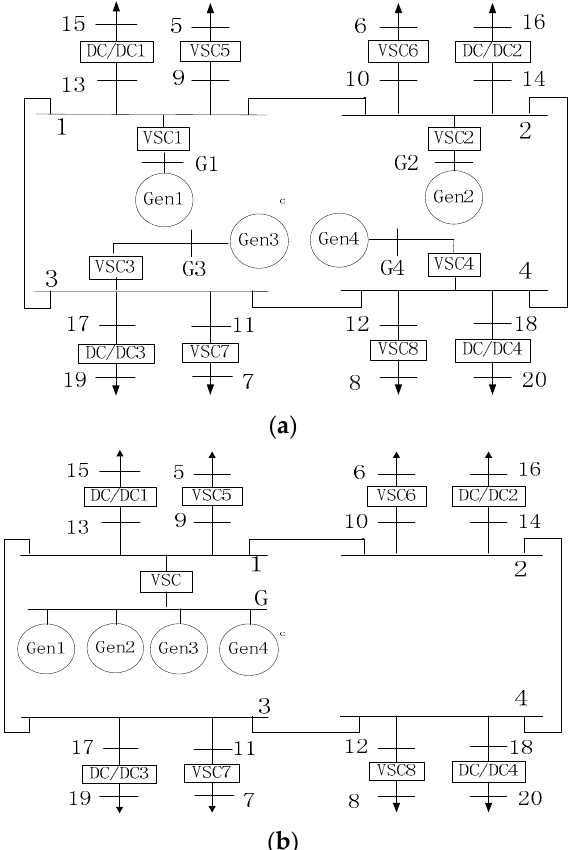
Figure 6. MVDC shipboard test systems. ( a ) Unit-connected generation scheme; ( b ) Group-connected generation scheme.